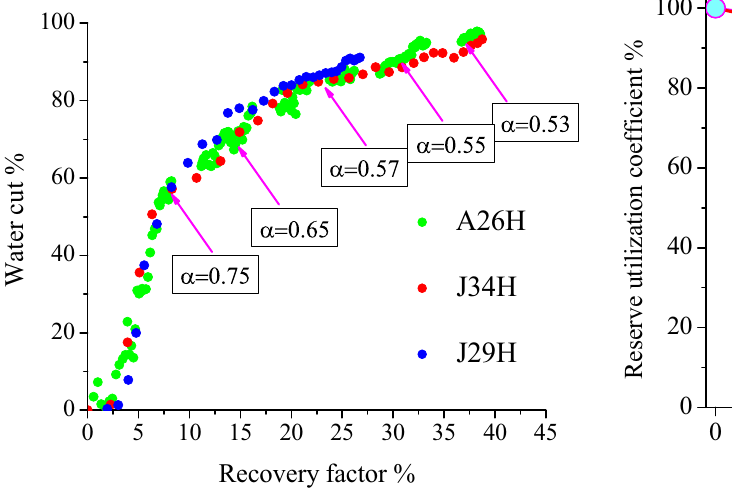
Fig. 6 How to estimate sweep efficiency of A26H well Fig. 7 Horizontal well